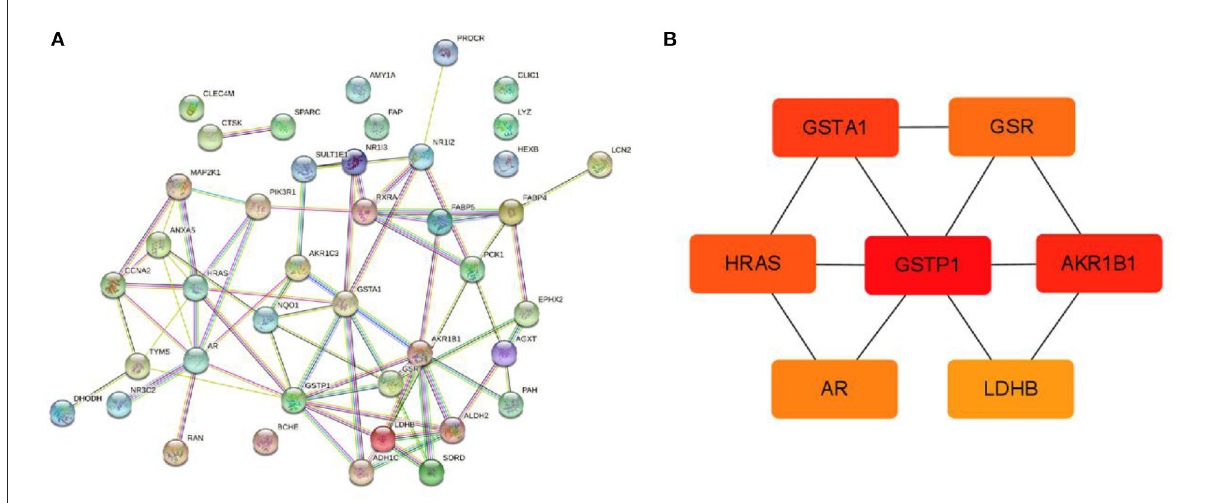
FIGURE12 Identification of hub genes from common DEGs. (A) The STRING database constructed a PPI network of the common DEGs. (B) Seven hub genes were identified by the Cytohubba tool in Cytoscape.